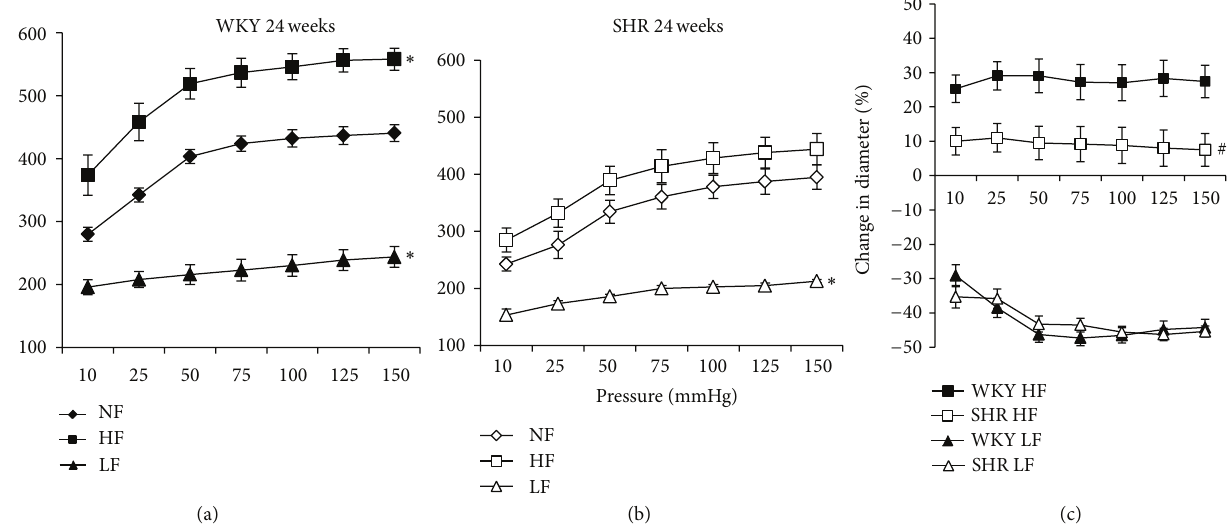
Figure 1: Pressure-diameter relationship determined in mesenteric resistance arteries isolated from normotensive rats (WKY: (a)) or spontaneously hypertensive rats (SHRs: (b)) submitted to arterial ligation for 1, 3, 8, or 24 weeks. Ligated arteries were designated as low- flow (LF) arteries. The artery located between two ligated vessels was designated as a high-flow (HF) artery. Other arteries had a normal flow (NF). Changes in diameter (C) due to remodeling in HF (positive values) and LF arteries (negative values) were calculated from the data shown in (a) and (b) and expressed as percentage change in diameter compared to NF vessels. Values representing mean ± SEM are shown ( 𝑛 = 12 rats per group). ∗ 𝑃 < 0.01 , HF or LF versus NF arteries. # 𝑃 < 0.05 , SHRs versus WKY, rats within equivalent arteries (NF, LF, or HF).